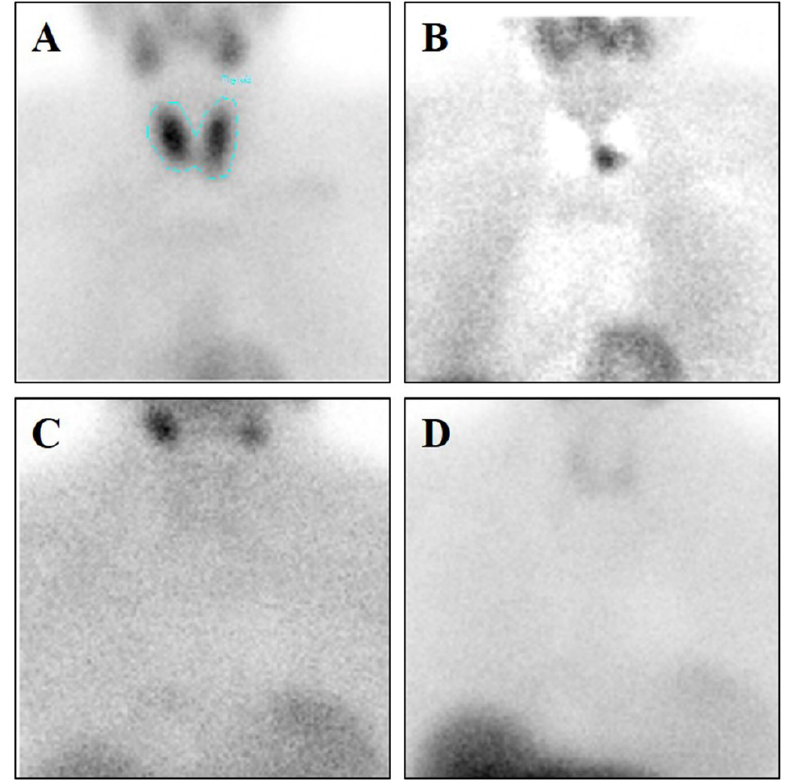
Figure 1. [ 99 mTc]Sestamibi Single Photon Emission Computed Tomography (SPECT) Analysis. ( A )